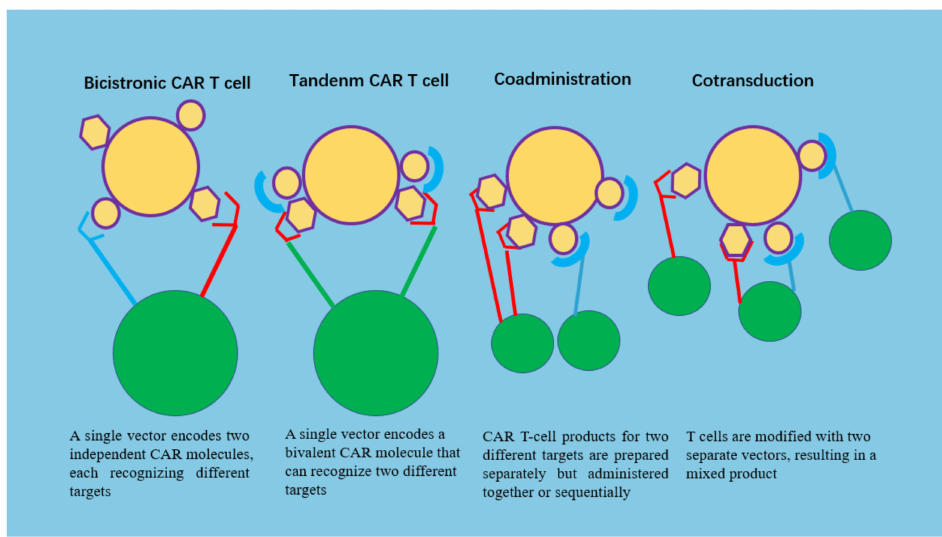
Figure 5. Different types of CAR-T cells are designed to inhibit immune